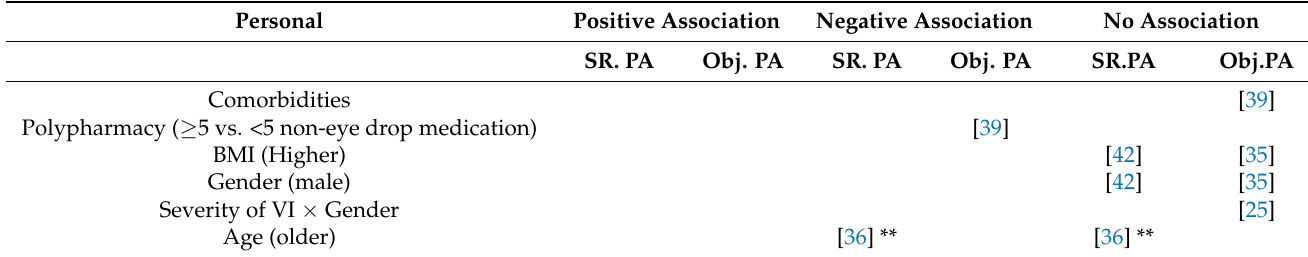
Table 6. Personal non-modifiable variables and their association with